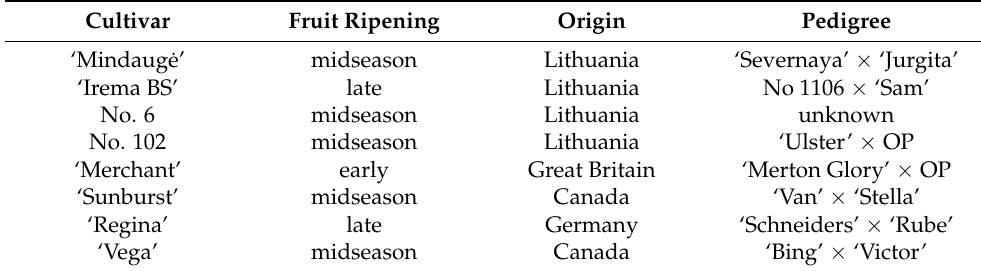
Table 8. Genetic resources [11,53]. OP—open pollination. Cultivar Fruit Ripening Origin Pedigree ‘Mindaug˙e’